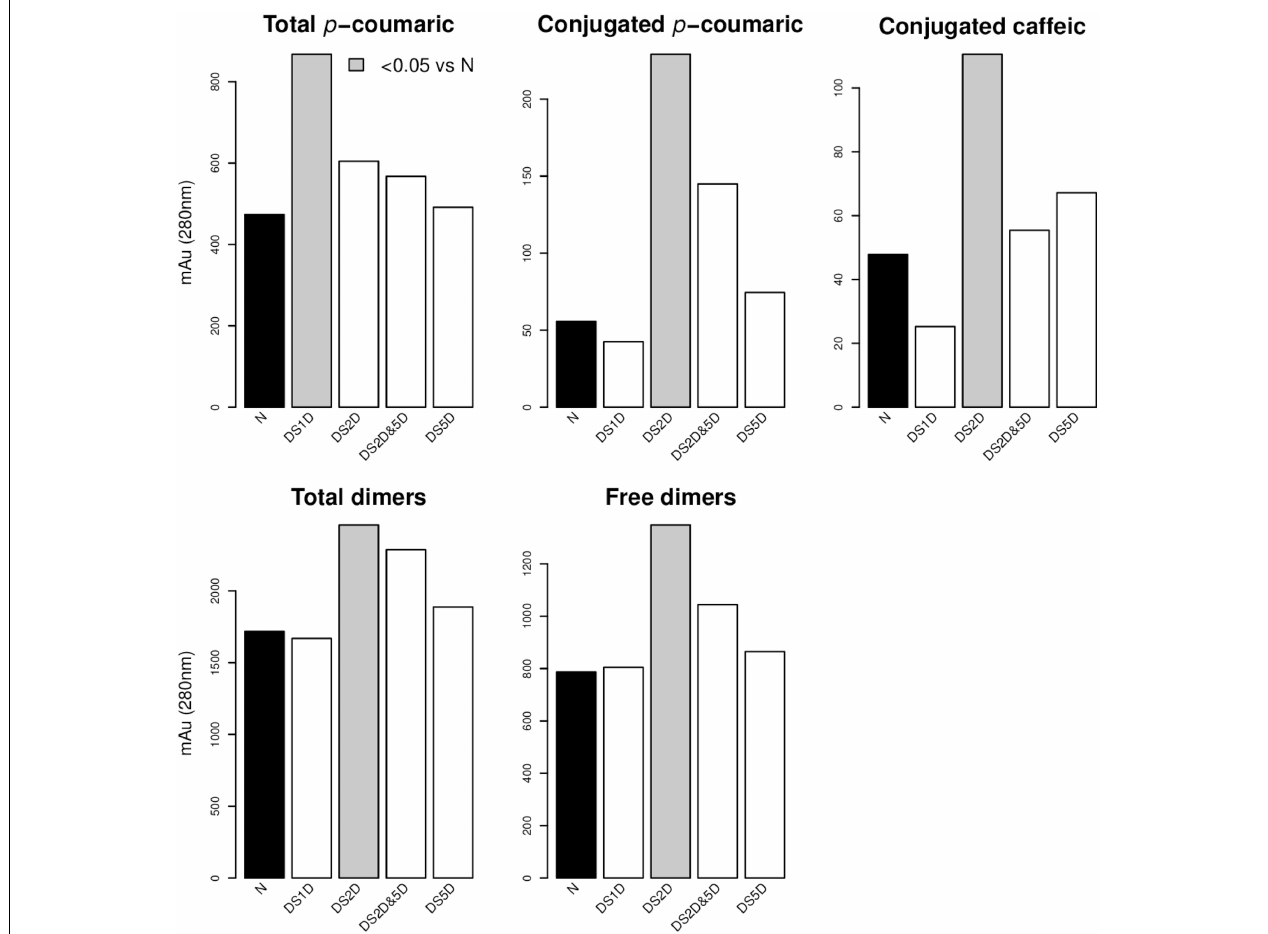
FIGURE 4 | Phenolic acid content and multiple-comparison results of the different substitution lines. Gray bars are significantly different ( p -value < 0.05 ) compared to the no substitution (N). Comparison of means (Tukey contrast) between levels of factor “Substitutions” took